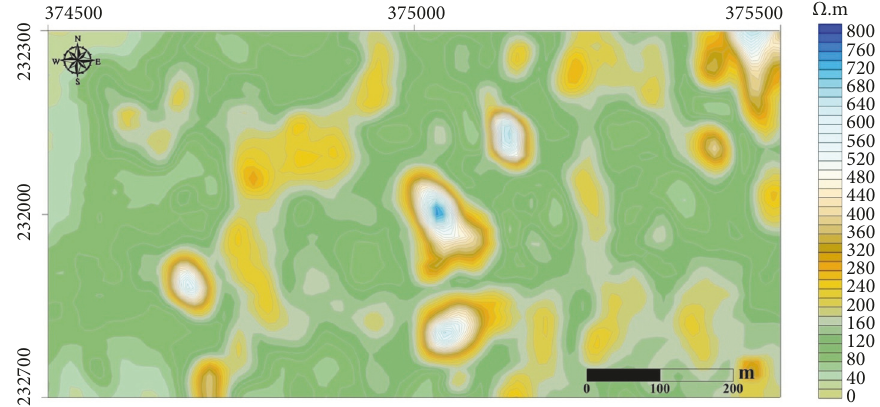
Figure 5: Apparent resistivity map of the study